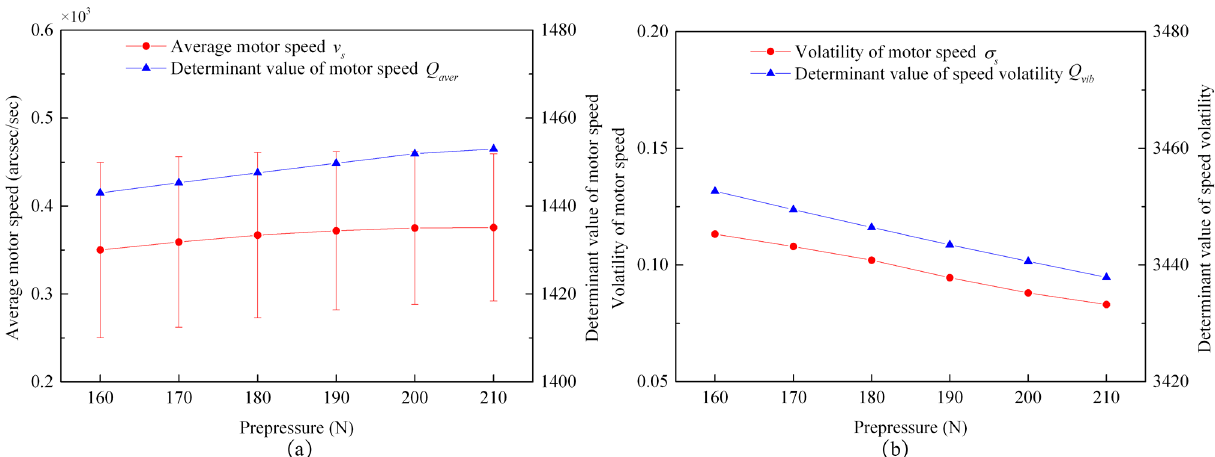
Figure 23. Simulation diagram of the characteristic variables changing with prepressure: ( a ) a simulation diagram of the motor’s average speed, v s , and the motor’s average speed determinant, Q aver , changing with the prepressure; and ( b ) a simulation diagram of the speed volatility determinant, Q vib , and the speed volatility, σ s , changing with the